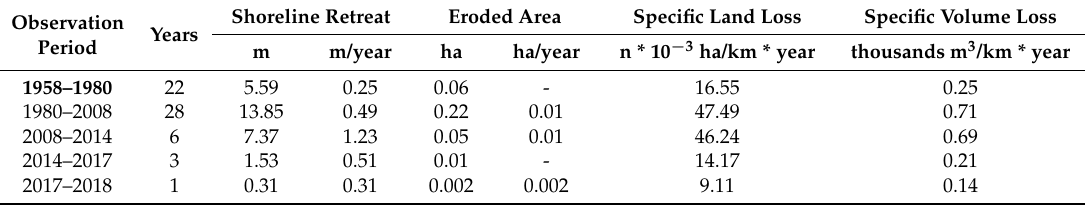
Table 6. Detailed morphometric indicators from different observation periods for Sector